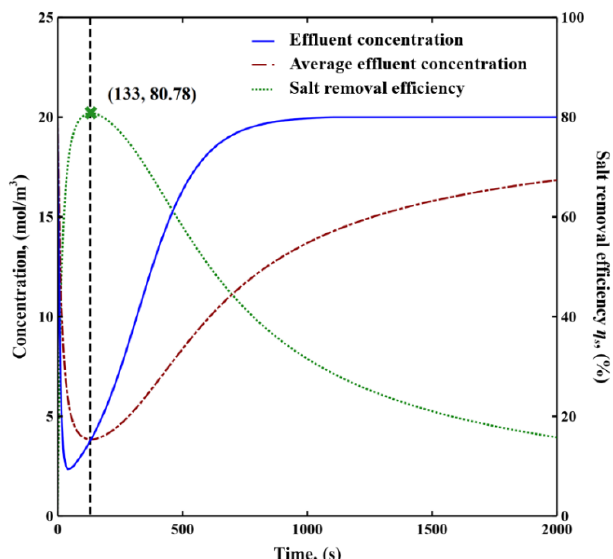
Figure 7. Transient effluent concentration, transient average effluent concentration, and transient salt removal efficiency curves of MCDI. The cross mark represents cycle time with the maximum salt removal efficiency. The applied voltage is 0.8 V, the flow rate is 10 mL/min, and the feed water concentration is 20 mol/m 3 .